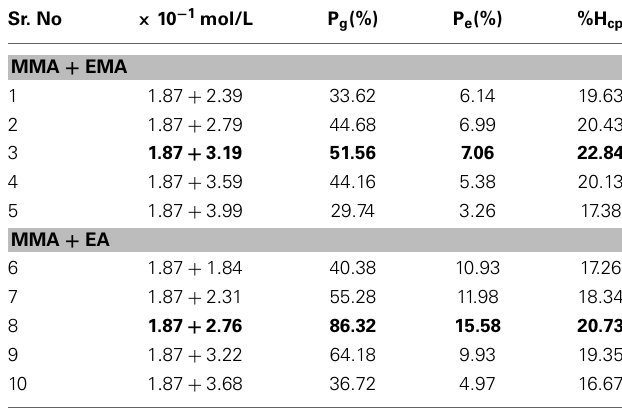
Optimal conditions for grafting: exposure time = 10min, microwave power